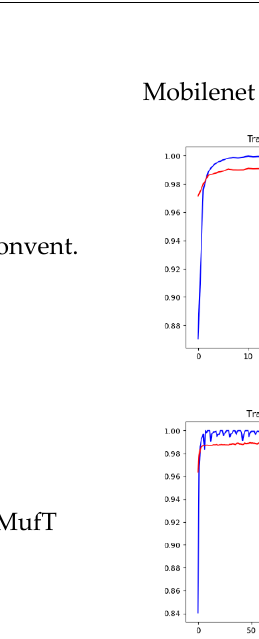
Figure 14. Performance when models were trained on the large PlantVillage dataset, using the conventional training (upper row) and YMufT strategies (lower rows).